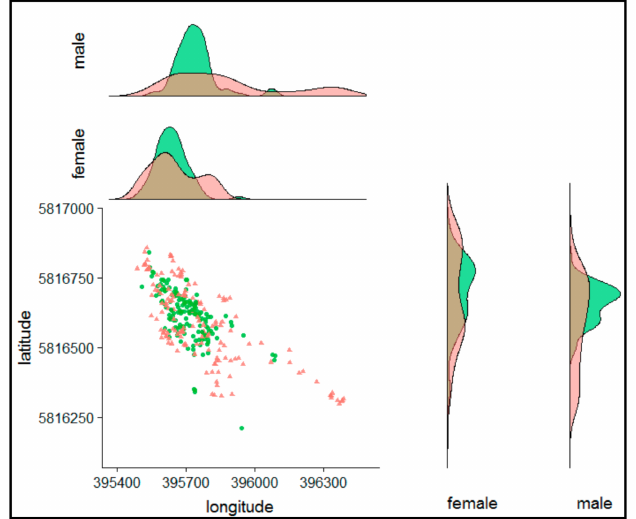
Figure 2. Centroid distribution. Circle / green = pre-festival period, triangle / red = festival period; density plots show the total of kernel density estimates (kde50) in the same